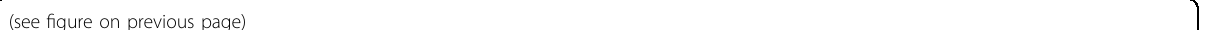
Fig. 5 Knockdown of CLEC3B could signi fi cantly attenuate the fi brogenesis of ASCs from lymphedema patients. a Schematic representation of the experimental procedure. ASCs from patients ( n = 3) were transfected with CLEC3B siRNA or scramble siRNA (negative control). The cells were harvested 48 h and 96 h after transfection for mRNA and protein analysis, respectively. b Images showing the ASCs after 96 h of transfection. Scale bar: 100 μ m. c Network plot showing the downregulated pathways in ASCs with siRNA-mediated knockdown of CLEC3B versus the negative control. Functional enrichment analysis was performed on the differential expressed genes detected by bulk RNA-seq. Adjusted P value < 0.05, the hypergeometric test. d Signi fi cantly reduced mRNA expression of c3 markers and fi brosis-related genes in ASCs with CLEC3B knockdown versus the negative control (determined by bulk RNA-seq). The signi fi cance threshold was set to be a P value < 0.05 of the sleuth differential expression test. e Signi fi cantly reduced mRNA expression of c3 markers and fi brosis-related genes in ASCs with CLEC3B knockdown versus the negative control (determined by qPCR). The signi fi cance threshold was set to be a P value < 0.05 of the one-tailed paired t -test. f Immunoblot assays showing the decreased protein expression of CLEC3B, Collagen-1, SMAD2/3, and phosphorylated SMAD2/3 in ASCs with CLEC3B knockdown versus the negative control ( n = 3). g Densitometry analysis of the immunoblot results. The signi fi cance threshold was set to be a P value < 0.05 of the one-tailed paired t -test. h Immuno fl uorescent staining of Collagen-1 in ASCs transfected with CLEC3B siRNA or scramble siRNA. Scale bar: 50 μ m. Representative fi elds of view of ASCs from the patient L21 are shown. i Collagen-1 staining fl uorescence intensity comparison. Each value represents the mean fl uorescence intensity of three representative fi elds of view. Two-tailed paired t